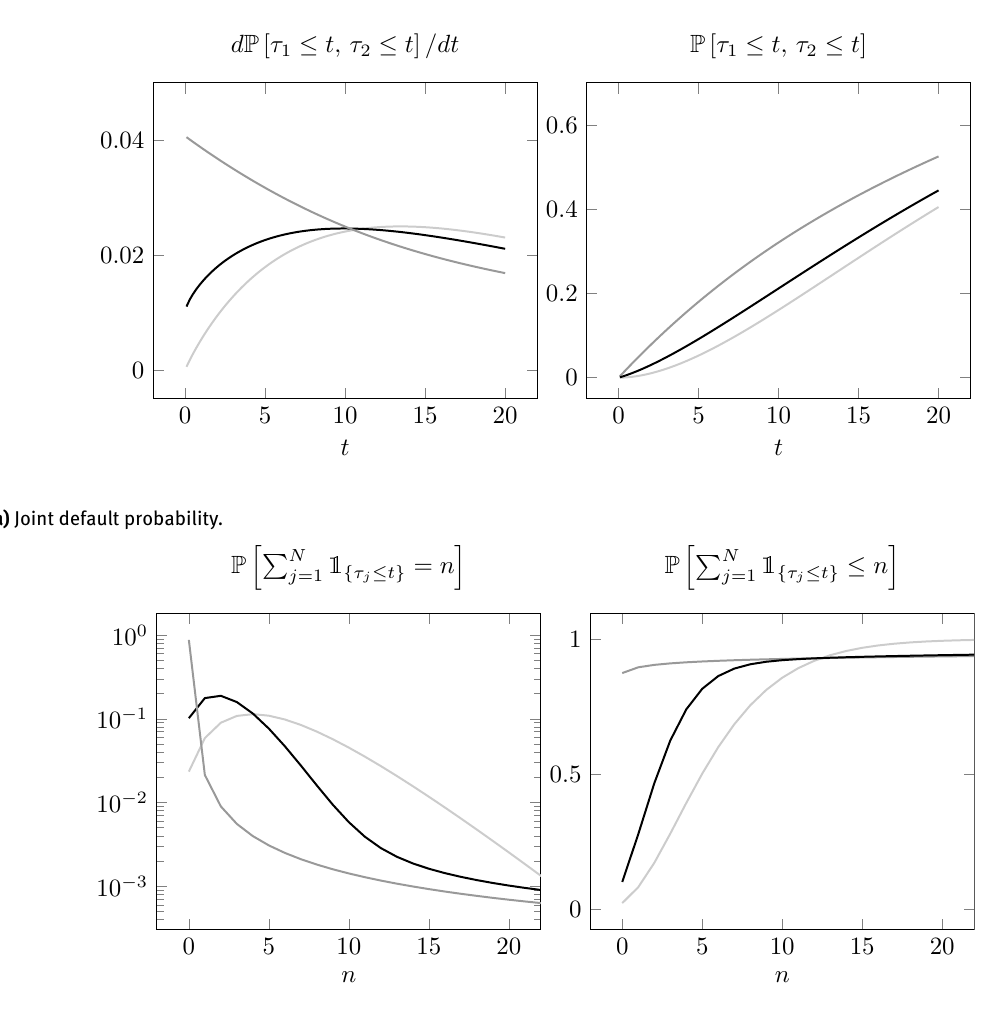
Figure 2: Dependent defaults with a copula mixture. The probability (left) and cumulative (right) density functions of the joint default of two homogeneous entities are displayed on Figure 2 (a) for time horizons ranging from 1 week to 20 years for three different one-factor models. The probability (left) and cumulative (right) density functions of the total number of defaults on a portfolio of 125 homogeneous entities are displayed on Figure 2 (b) at a 5-years horizon. The marginal default probability is given by p = 0.05 for all j ∈ I and the reference factor j , t copula models is an equiweighted copula mixture (black line) between a Gaussian copula with ρ = 0.25 (light-grey line) and a Clayton copula with parameter equal to 5 (grey